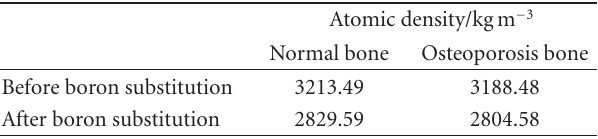
Table 3: E ff ect of boron on atomic density in hydroxyapatite of osteoporosis and normal bone.